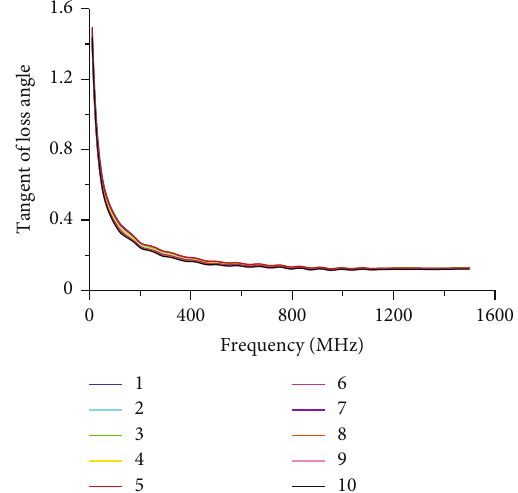
Figure 7: The sample #5 tangent of loss angular changing with frequency under 10 repeated